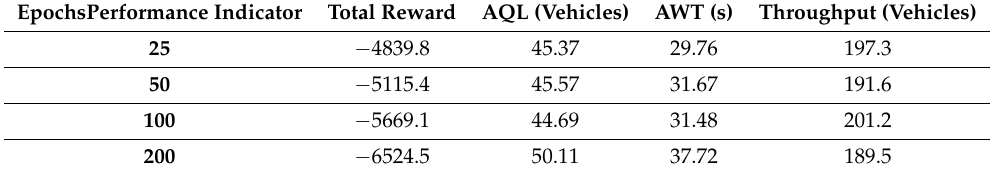
Table 9. Average performance of model trained with different number of epochs using action time step 1 s.